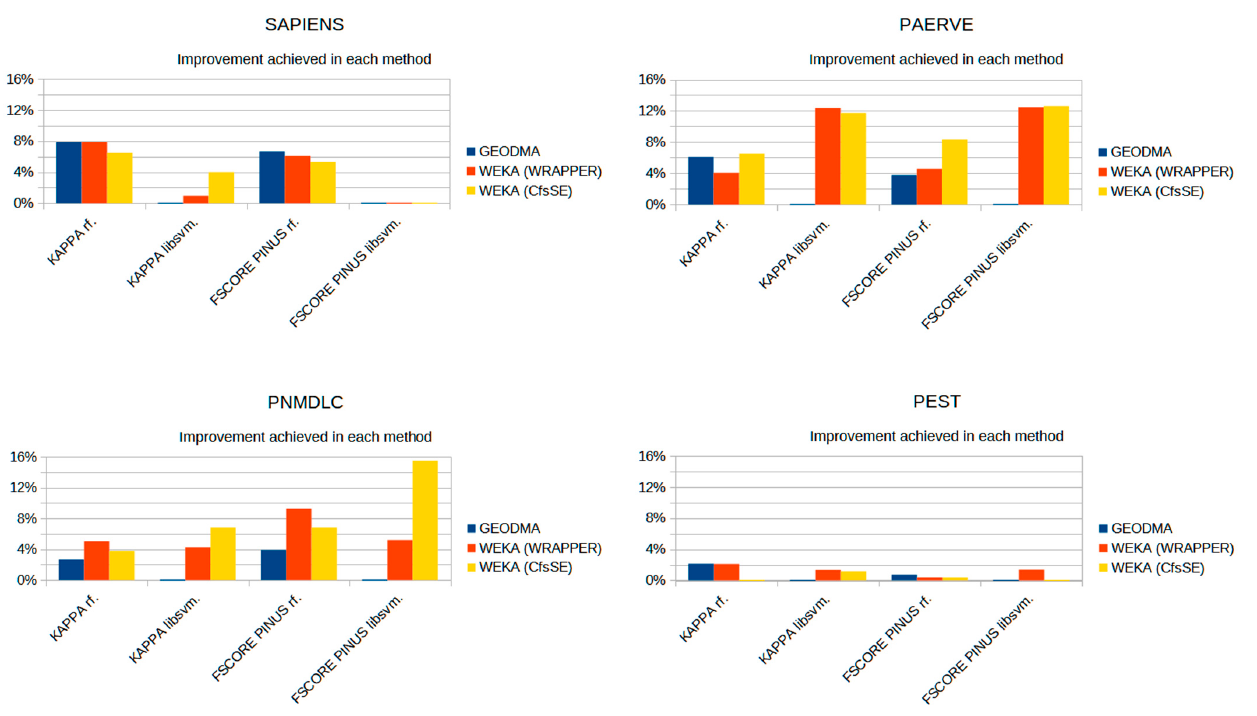
Figure 5. Relative percentage graphs showing improvement obtained for each method in each area of interest.